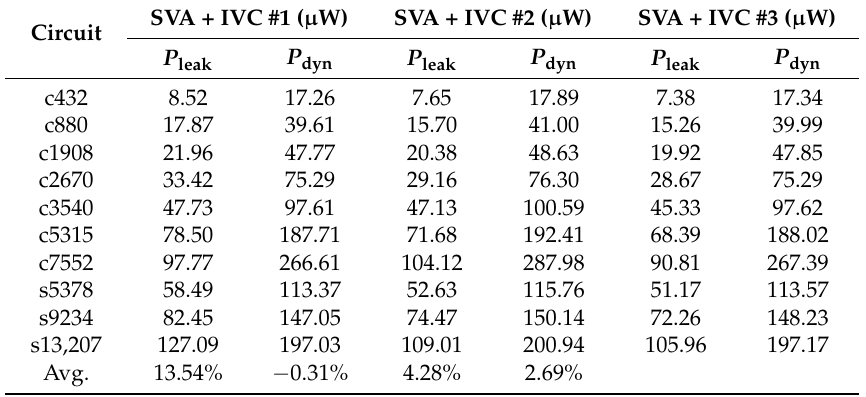
Table 7. Leakage and dynamic power of SVA combined with different ILP formulations ( R AS = 1.0).